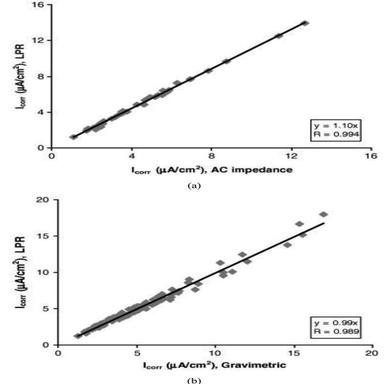
Variation of Icorr between (a) LPR and AC impedance, (b) LPR and gravimetric.